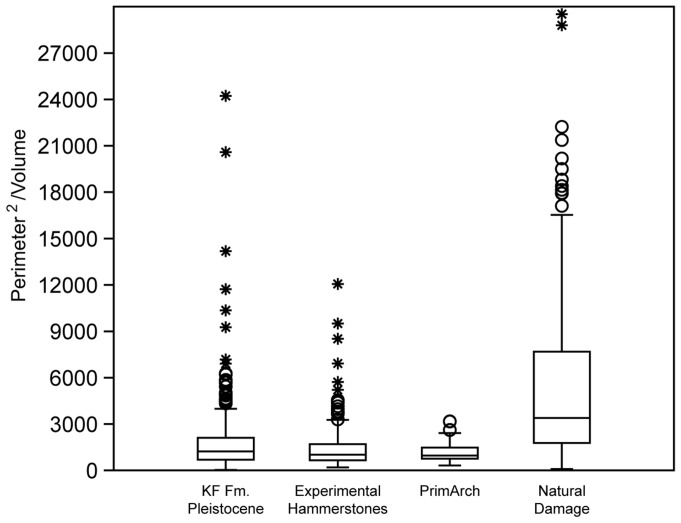
Box-plot of hotspot polygon perimeter to area ratio values.Boxes represent the interquartile range of values for the four samples (archaeological specimens from Pleistocene deposits of the KF Fm.; experimental percussive specimens; PrimArch specimens from the KF Fm. (>2.2 Ma); and naturally damaged specimens).